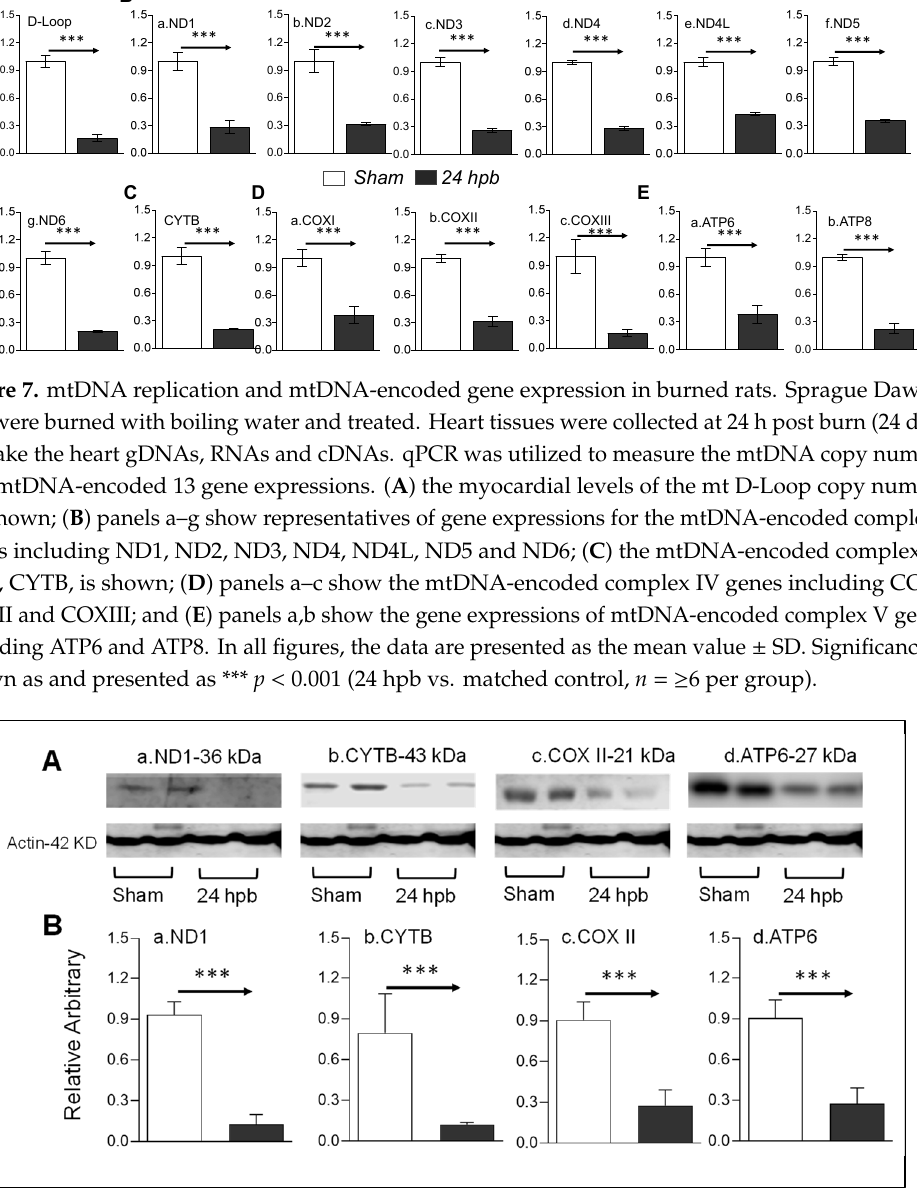
Figure 8. mtDNA-encoded proteins in burn injury myocardium. Rats were burned with boiling water and harvested at 24 h post burn: ( A ) Western blotting—heart tissue homogenates were subjected to Western blotting with anti-ND1antibody ( Aa ), anti-CYTB antibody ( Ab ), anti-COX II antibody ( Ac ) and anti-ATP6 antibody; ( B ) densitometry analysis of the panel A signals ( Ba – Bd ) is presented. Densitometry analysis of the WB bands in the heart homogenates were normalized to β -actin. Data are plotted as the mean value ± SEM (n = 6–10 rats per group). Significance is shown as *** p < 0.001.